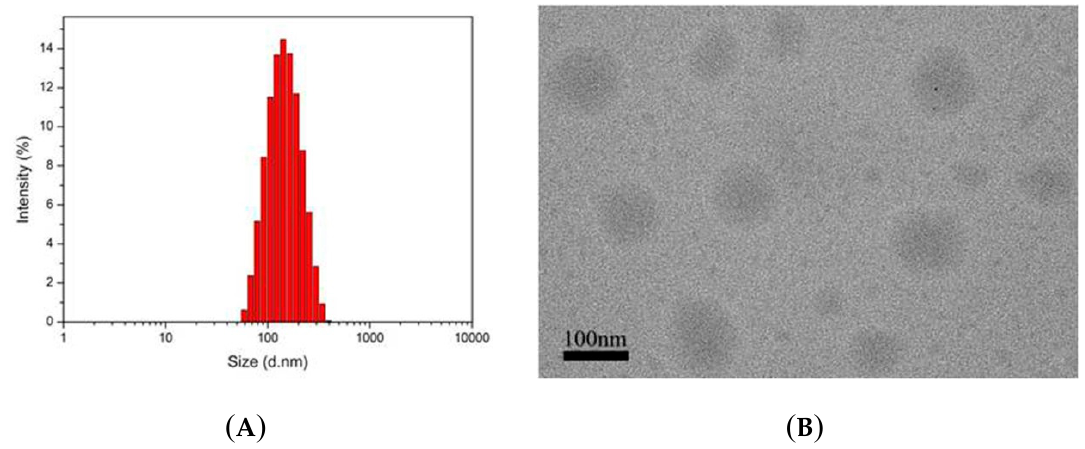
Polymers 2018 , 10 , x FOR PEER REVIEW Figure 4. FT-IR spectra of mPEG-APCL and mPEG-PCL-Imi-DOX (24.2 wt % DOX content).